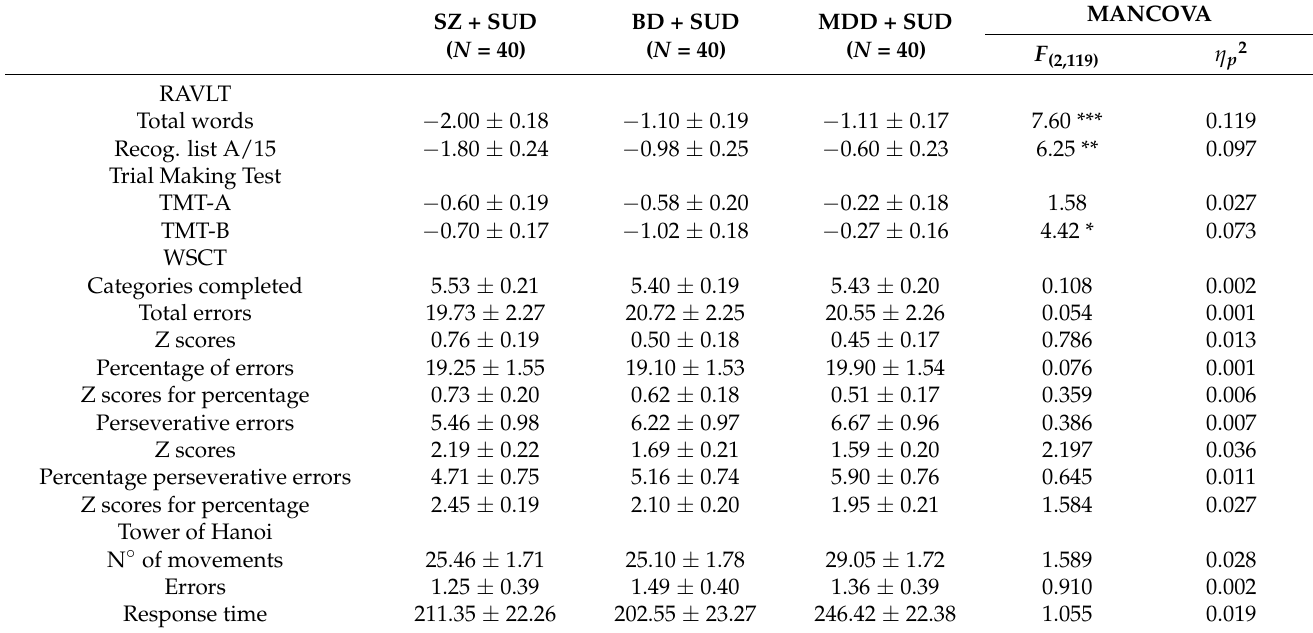
Table 4. Results for the three groups of patients in: RAVLT (Rey Auditory Verbal Learning Test), Trial Making Test (TMT A and B), Wisconsin Card Sorting Tests (WCST) and Tower of Hanoi. Means (in Z scores), standard error and statistical contrasts of the MANCOVA (Multiple Analysis of